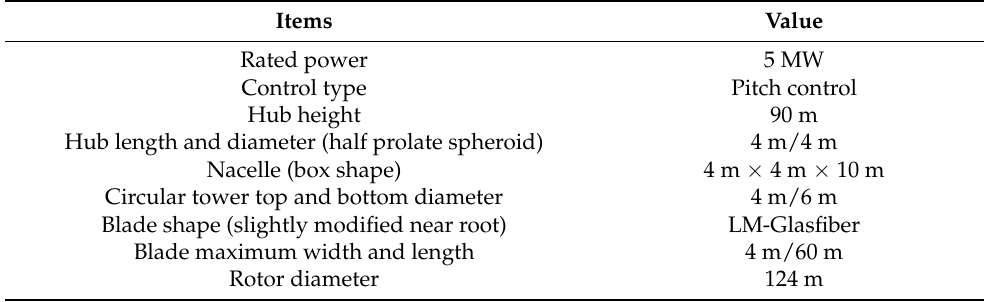
Table 1. Details of wind turbine (in full